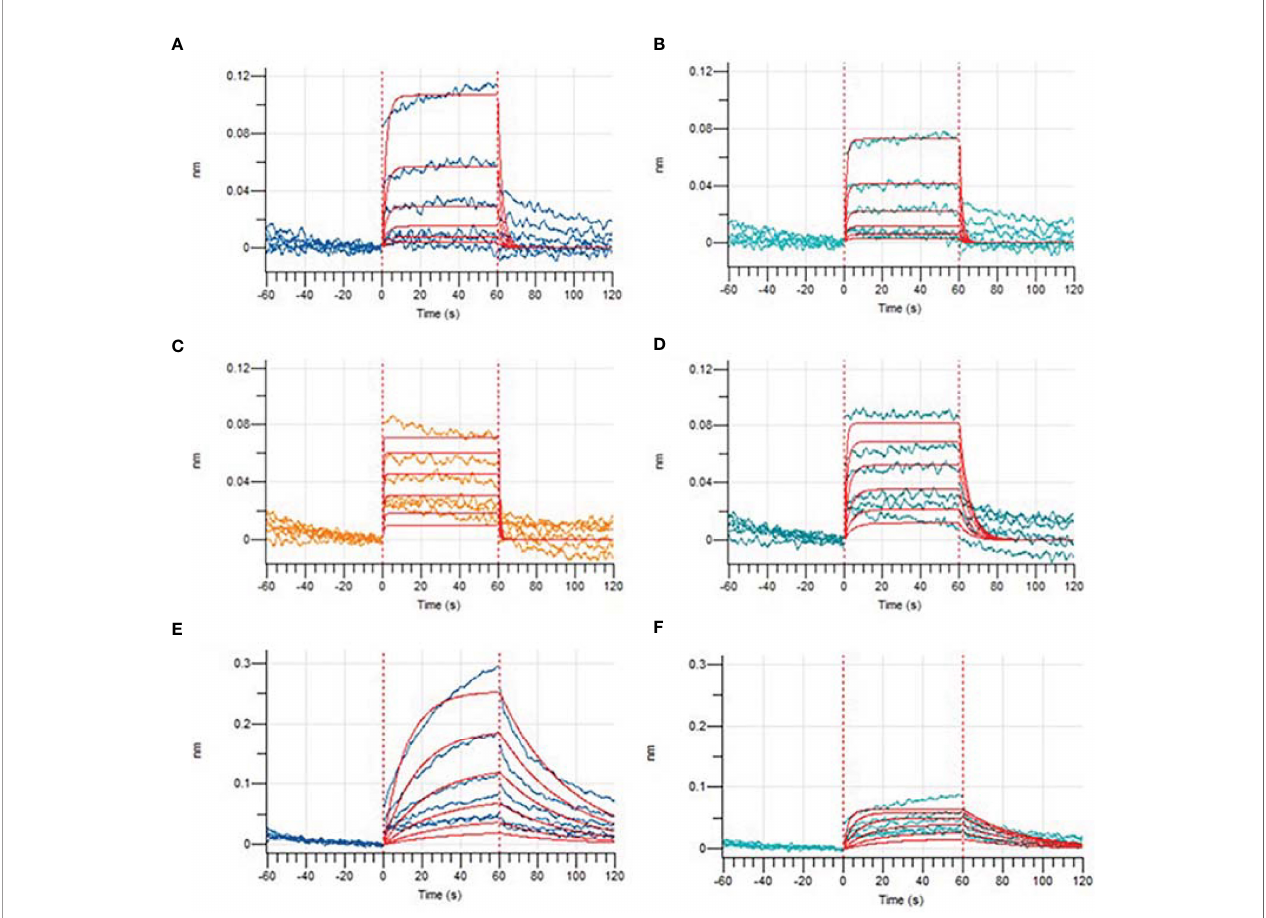
FIGURE 7 | Binding af fi nities of epitopes before and after mutations obtained by Bio-Layer Interferometry (BLI). Binding dissociation curve between wild-type peptide GVSPTKLNDL (A) , KCYGVSPTK (C) , FSTFKCYGV (E) , mutated epitope GLSPTKLNDL (B) , KCYGLSPTK (D) , and FSTFKCYGL (F) and HLA-A*11:01. TABLE 4 | Kinetic analysis by BLI of the binding studies of epitopes to HLA molecular. Wild Peptide